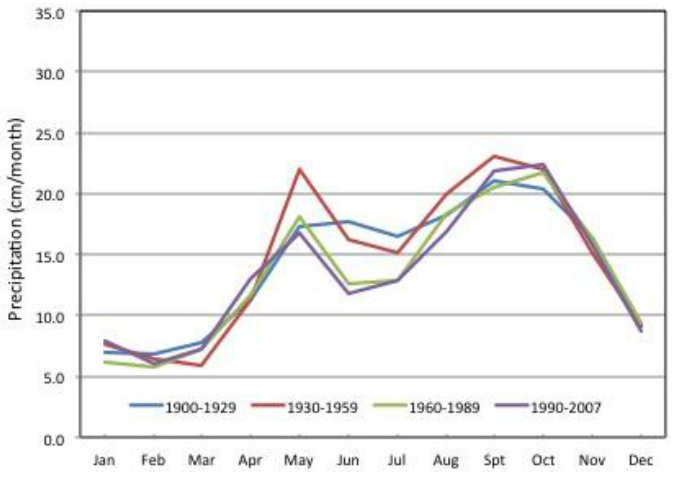
Figure 14. Puerto Rico annual cycle monthly precipitation by